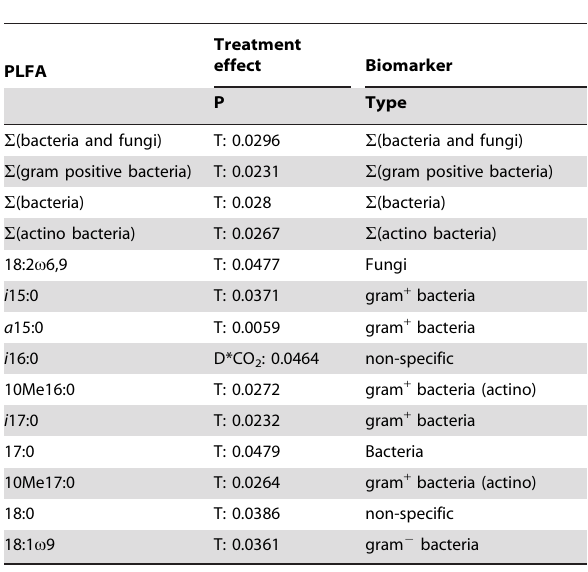
Table 1. Significant effect of climate change treatments (P- values) on PLFA 13 C enrichment from soils from the CLIMAITE experiment sampled in August 2007.